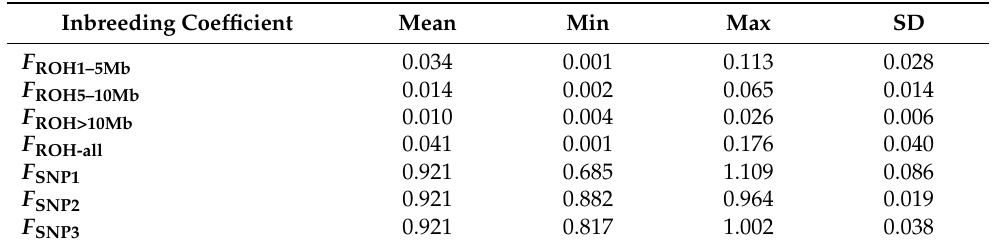
Table 1. Descriptive statistics for the seven types of inbreeding coefficient estimates calculated from the identified ROHs ( F ROH-all , F ROH1–5Mb , F ROH5–10Mb , and F ROH>10Mb ), and the SNP information ( F SNP1 , F SNP2 , and F SNP3 ).